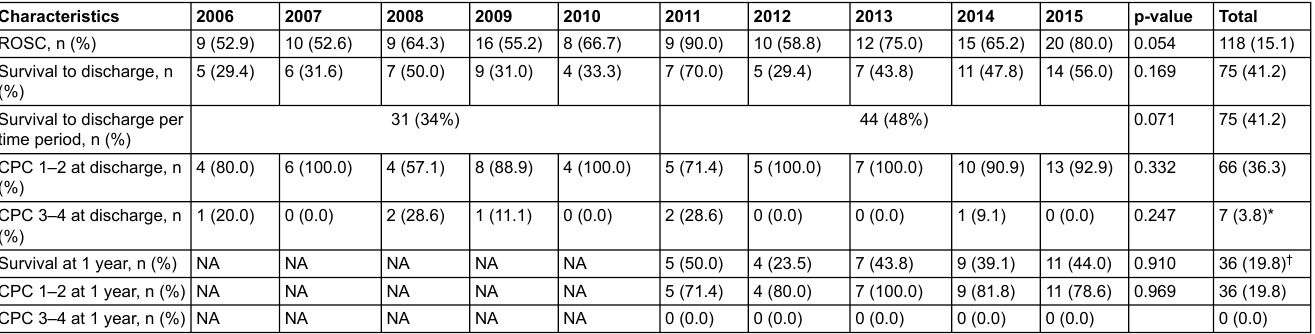
Table 3: Outcome data from our cardiac arrest database. Characteristics